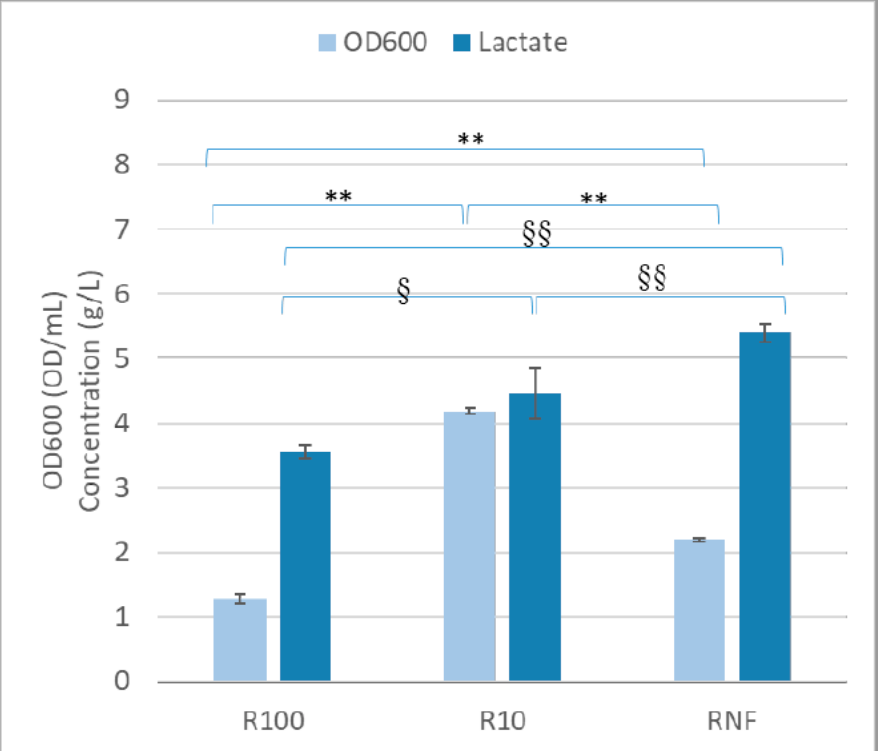
Figure 4. Growth of L. rhamnosus IMC501 on retentate fractions after pasteurization. Data were analyzed by two-tailed non homoscedastic Student’s t -test. ** indicates p < 0.005 (OD600 results); § indicates p < 0.05 (lactate results); §§ indicates p < 0.005 (lactate results).